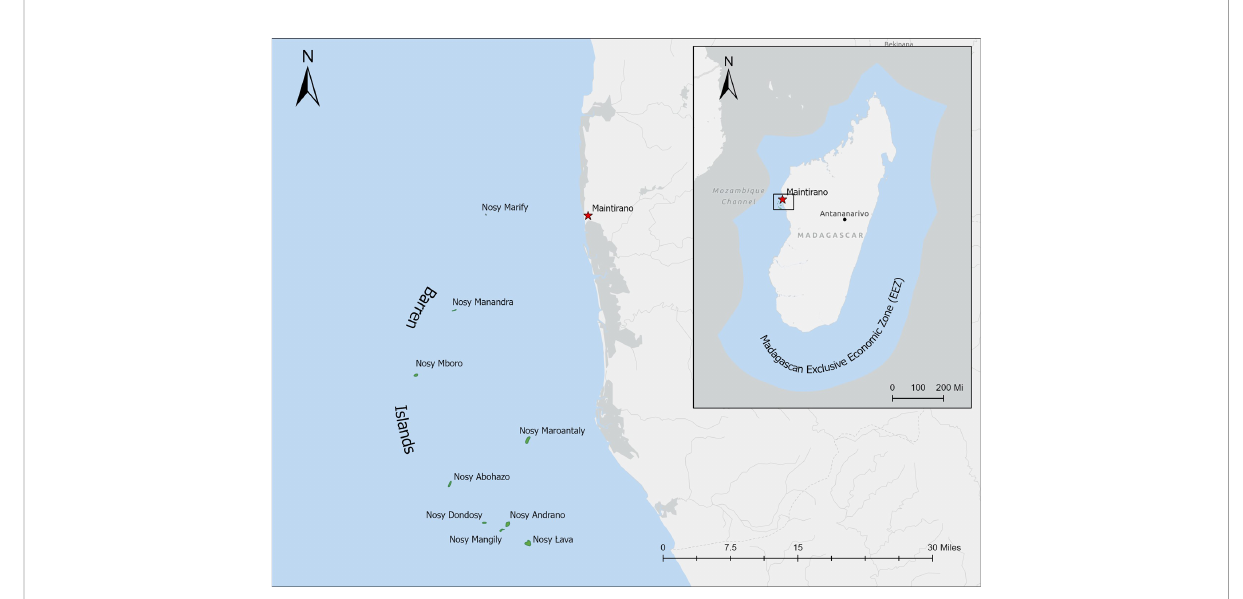
FIGURE 1 Map of Nosy Barren, also known as the Barren Iles or Barren Islands, of